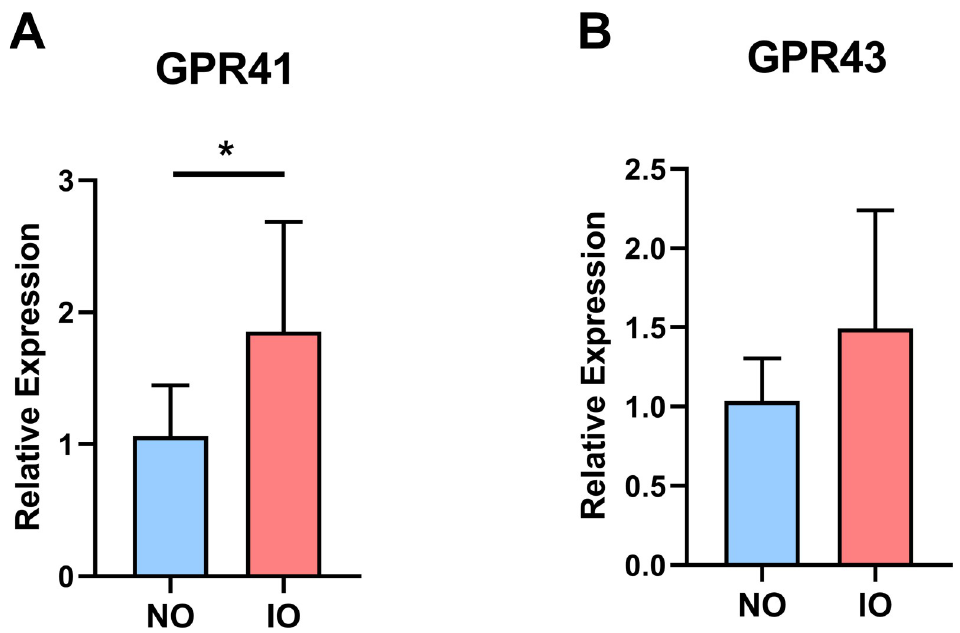
Fig 3. Expression of GPR41 and GPR43 in the lungs of offspring in the asthma model. (A) The relative expression of GPR41 mRNA in the lungs of the IO group was higher than that of the NO group (p < 0.05). (B) The relative expression of GPR43 mRNA in the lungs of the IO group was higher than that of the NO group (p > 0.05).